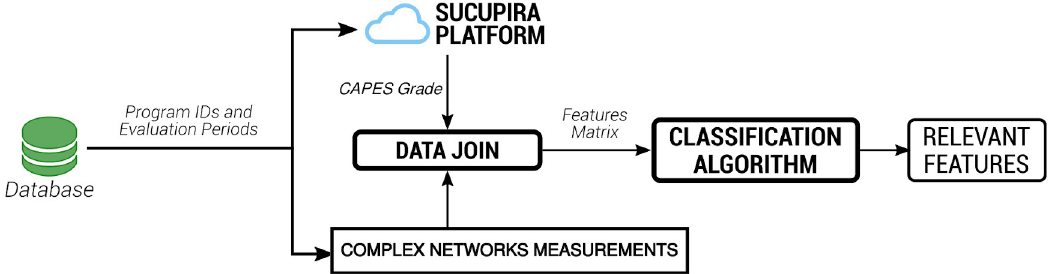
Fig 2. Process flow for topological metrics analysis. Note that the data saved in the database is used as a filter for downloading CAPES grade from the internet and identifies each program with its topological measurements. This data is gathered into a feature matrix and the algorithms